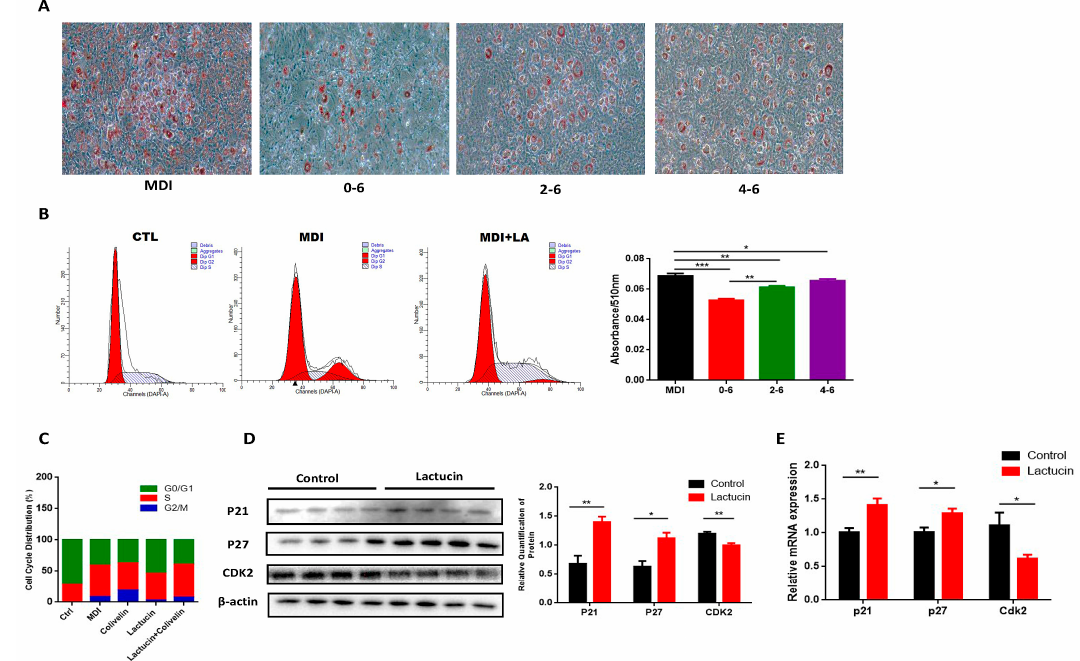
Figure 4. Lactucin promotes G0 / G1 phase arrest through regulation of p21, p27, and CDK2. The 3T3-L1 preadipocytes were induced to di ff erentiate with MDI and treated with 20 µ M of lactucin for indicated times. ( A ) Morphological observation and Oil Red O staining of 3T3-L1 adipocytes photographed using a microscope ( × 100). Lipid droplets were stained in red. The absorbance of extracted ORO accumulated in lipid droplets of 3T3-L1 adipocytes was measured spectrophotometrically at 510 nm. ( B ) The cell cycle analysis using flow cytometry. ( C ) Percentage of cells in G0 / G1, S and G2 / M phases measured using FlowJo V10 software. ( D , E ) The mRNA ( n = 6) and protein levels ( n = 4) of genes related to cell cycle progression. Values are mean ± S.E.M. * p < 0.05, ** p < 0.01, *** p < 0.001.